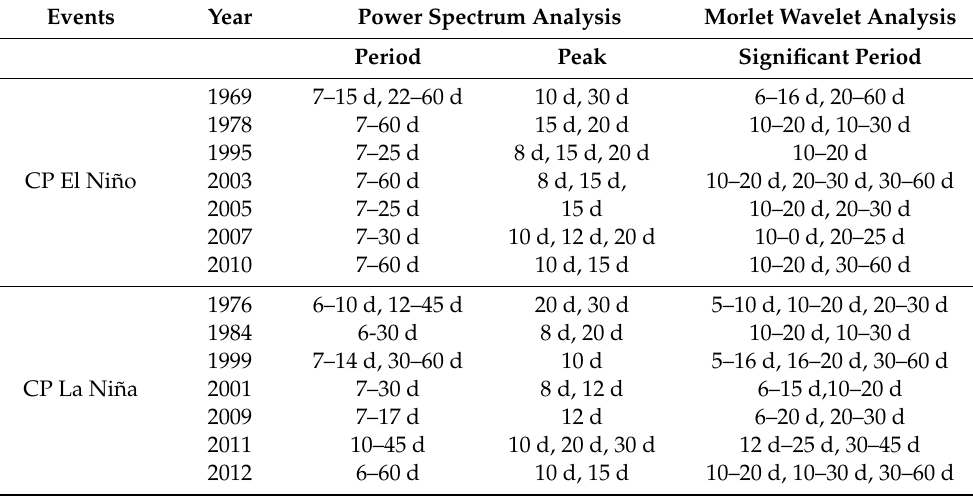
Table 2. Power spectrum and wavelet analysis of daily precipitation in the eastern China during the following summer of CP